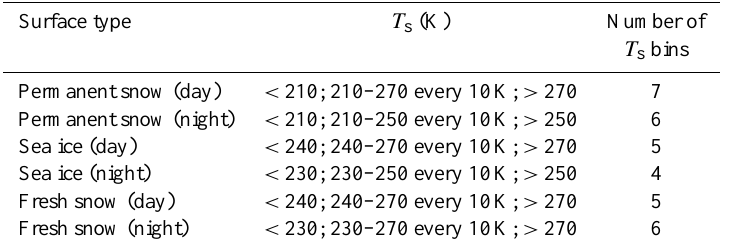
Table 4. Surface skin temperature ( T s ) intervals used to determine LW and WN ADMs under clear-sky conditions over permanent snow, sea ice, and fresh snow.